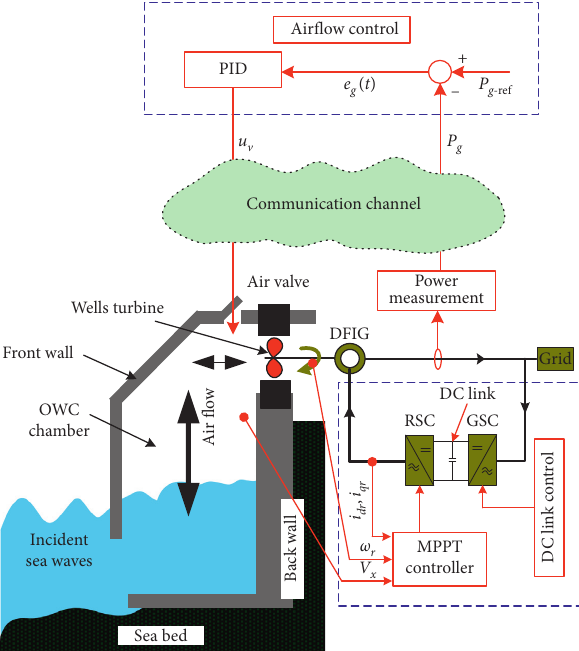
Figure 1: Different configurations of an individual OWC plant and its control